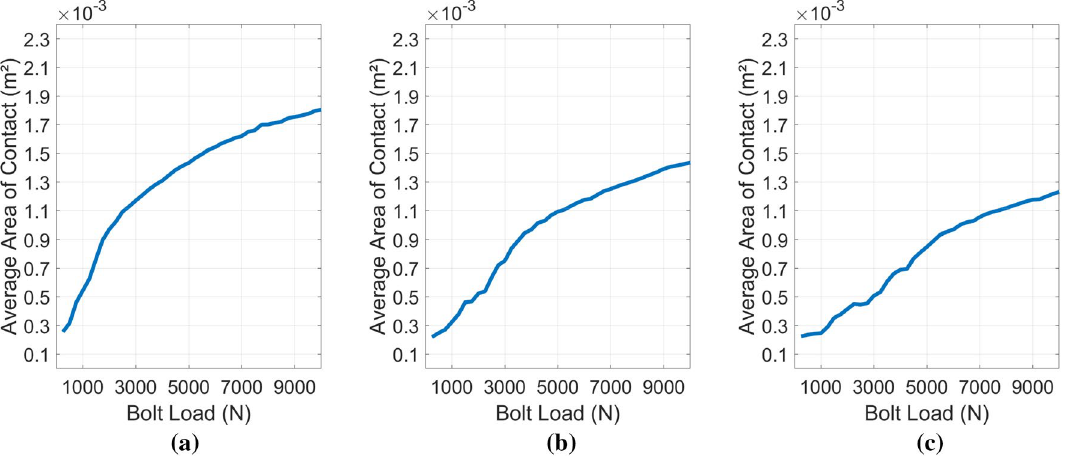
Fig. 11 The average area of contact ( m 2 ) over 0.05 s with a 500 N, b 1000 N and c 1500 N excitation amplitude, the first mode of vibration